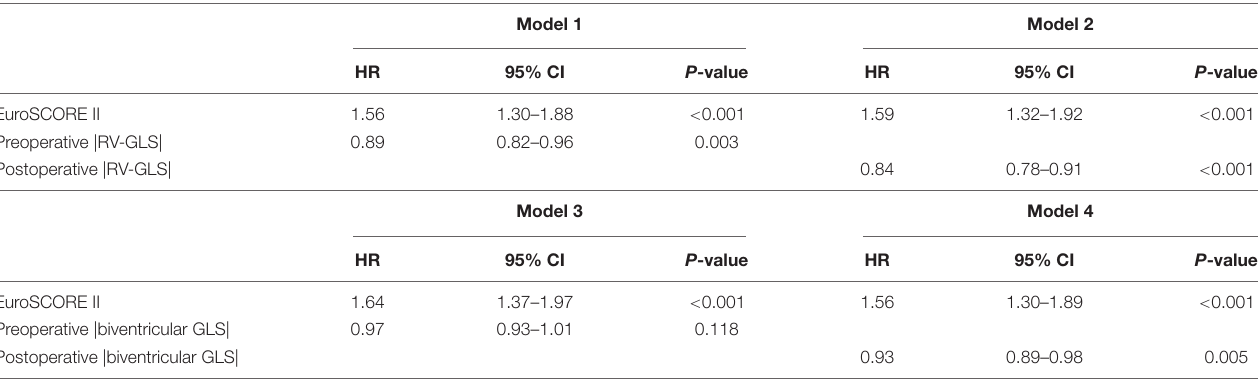
TABLE 3 | Multivariable Cox regression models for clinical